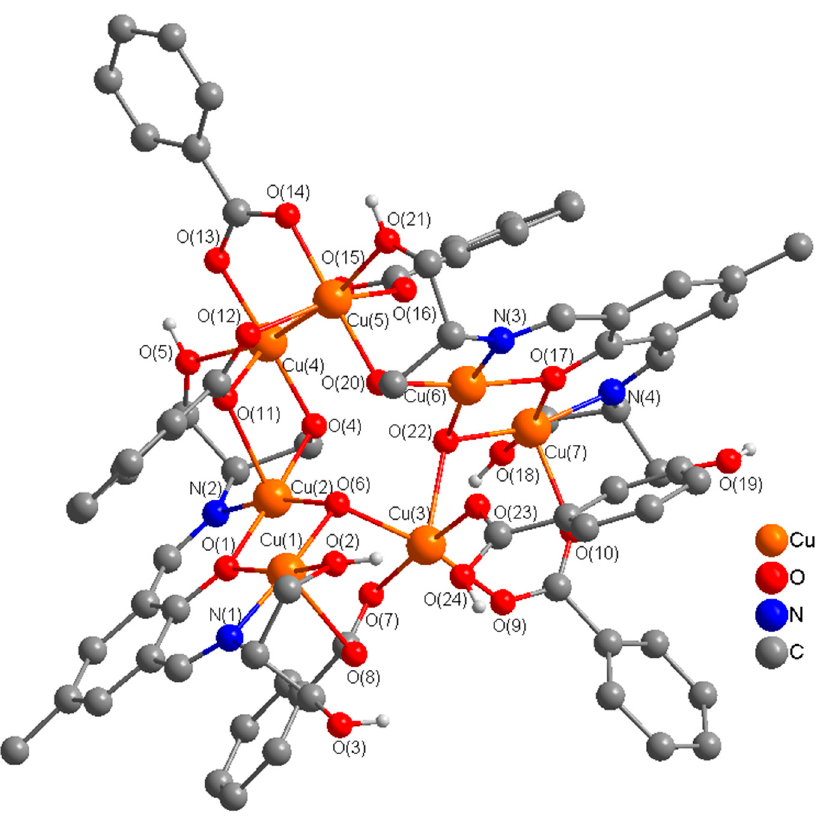
Figure 9. Perspective view of a heptanuclear complex [Cu 7 (H 3 L1 2 − ) 2 (O) 2 (C 6 H 5 CO 2 ) 6 ] ( 5) with relevant numbering. H-atoms and solvent molecules are omitted for clarity.